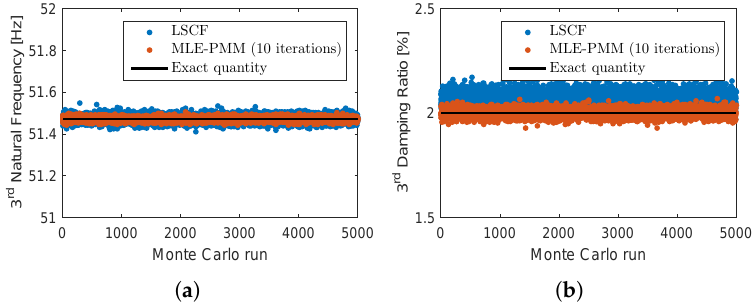
Figure 4. Monte Carlo simulation results for the 3rd identified natural frequency ( a ) and damping ratio ( b ): exact quantity (solid black line), LSCF estimates (blue dots) and MLE-PMM estimates after 10 iterations (red dots).